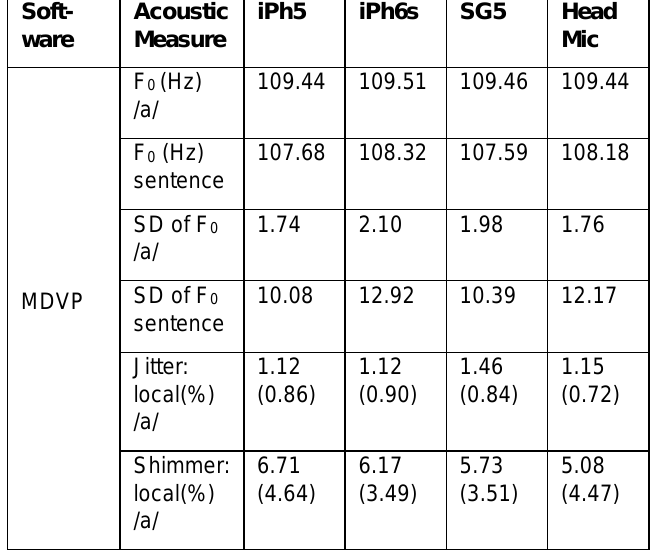
Table 3. Means and Standard Deviations (in Parentheses) of the Dependent Variables for Men across Utterance (i.e., /a/ and “we were away a year ago”), Software (i.e., Multi- dimensional Voice Program (MDVP), Analysis of Dysphonia in Speech and Voice (ADSV), and Praat), and Recording Device (i.e., iPhone5 (iPh5), iPhone6s (iPh6s), Samsung Galaxy5 (SG5), and Head-mounted Microphone